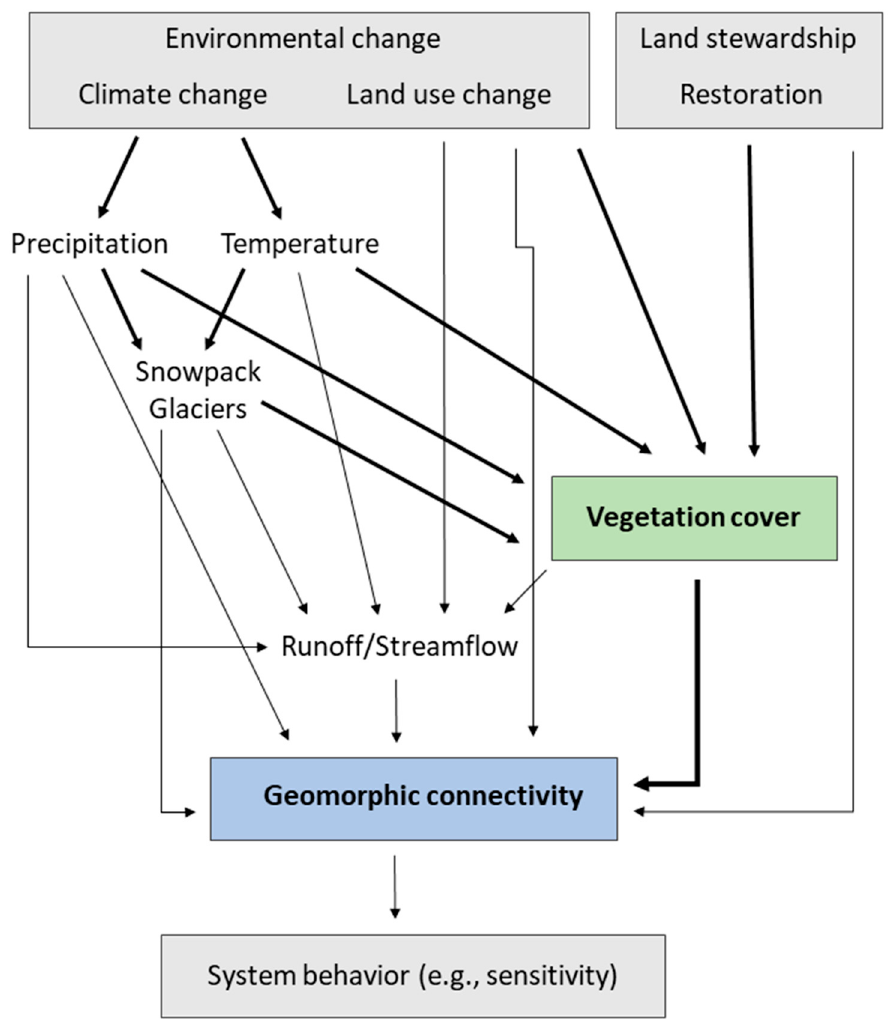
Figure 2. A simplified conceptual model illustrating the role of vegetation in mediating various effects of environmental change and land stewardship efforts (e.g., restoration) on geomorphic connectivity and, ultimately, the overall behavior of the fluvial landscape system. The pathways mediated by vegetation are represented by bold arrows.